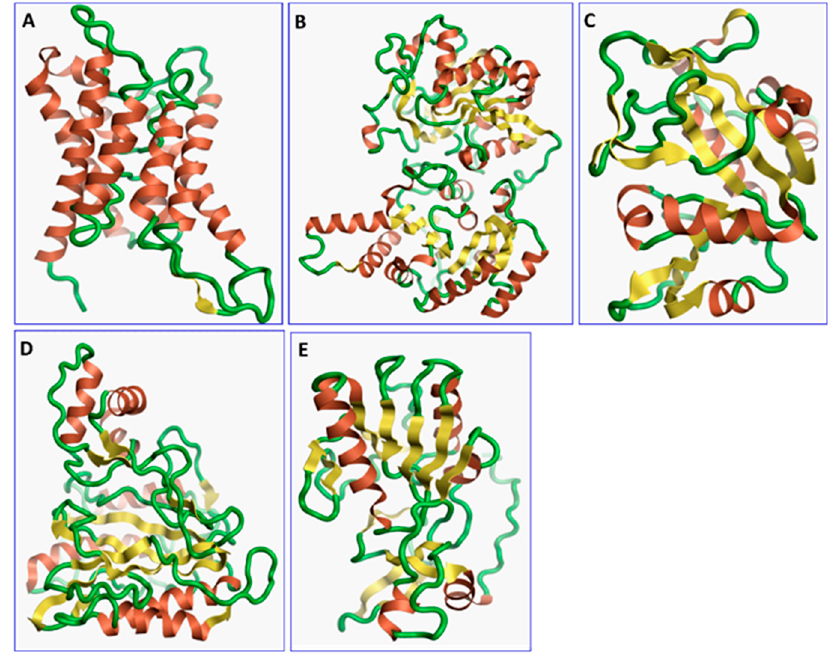
Figure 1. The three-dimensional structures of the five different protein targets—( A ) AQP protein, ( B ) CTP synthase, ( C ) DHFR, ( D ) MetAP2, and ( E ) TK—of EHP generated using AlphaFold 2. The α -helices are depicted as red coils, while the β -strands are represented as yellow arrows.